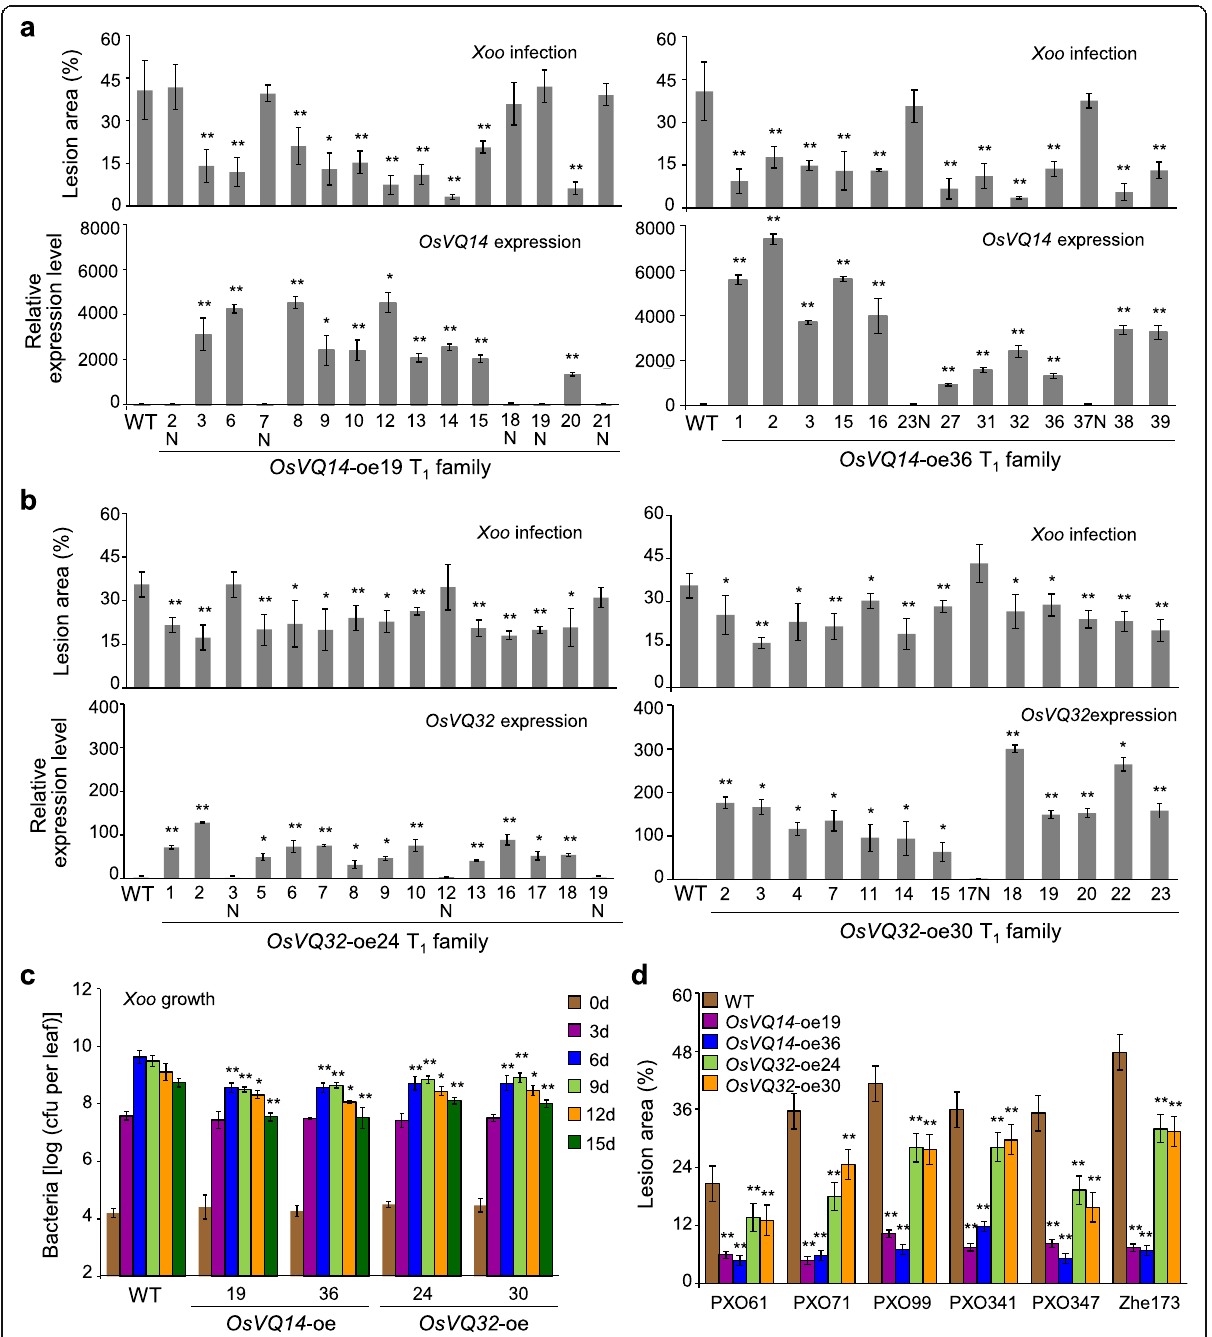
Fig. 1 Overexpressing OsVQ14 and OsVQ32 enhanced rice resistance to Xoo . The asterisks “ ** ” or “ * ” indicate a significant difference between transgenic plants and wild type (WT; Zhonghua 11) plants at P < 0.01 or P < 0.05, respectively. N, negative siblings segregated from the T 1 families. a and b The enhanced resistance of the transgenic plants to Xoo is associated with OsVQ14 expression ( a ) and OsVQ32 expression ( b ) in two T 1 families. Bars represent mean (3 to 5 leaves from one plant for lesion area, and 3 replicates for expression level)± standard deviation (SD). c Analysis of the Xoo growth in leaves of OsVQ14 -oe and OsVQ32 -oe plants. Bars represent mean (3 leaves from 3 positive plants) ± SD. The significant difference was detected between transgenic plants and WT with the same treatment. cfu, colony-forming unit. d Analysis of the response of OsVQ14 -oe and OsVQ32 -oe plants to different Xoo strains. Bars represent mean (3 plants, with each plant having 3 to 5 leaves for lesion area) ±